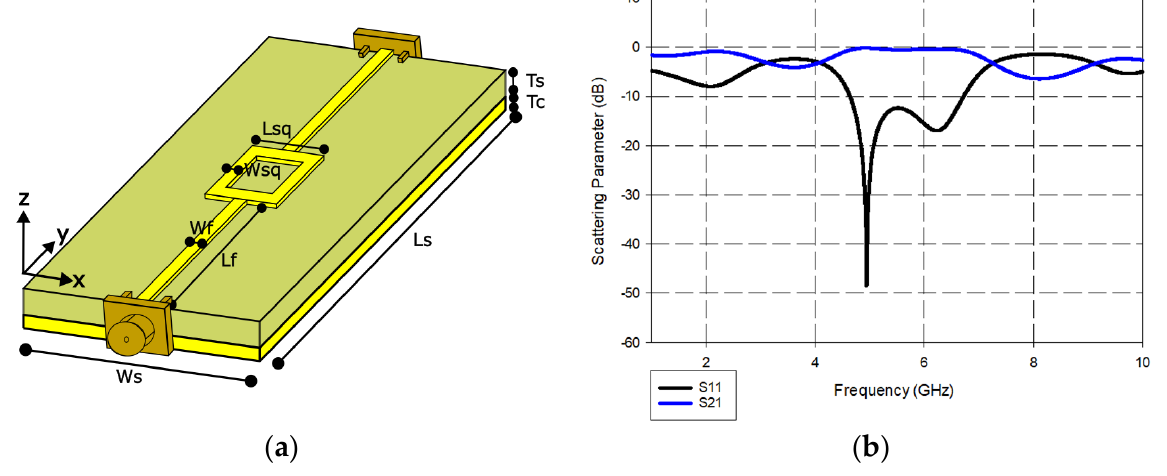
( b ) Figure 6. The ( a ) unconnected microstrip feed line structures and ( b ) its sca tt ering parameter re- sponse. Figure 7 shows the S-SRR with the microstrip transmission line connected. The width, Wf = 1.86 mm, is the same, but the length, Lf = 22.81 mm, is longer because there is